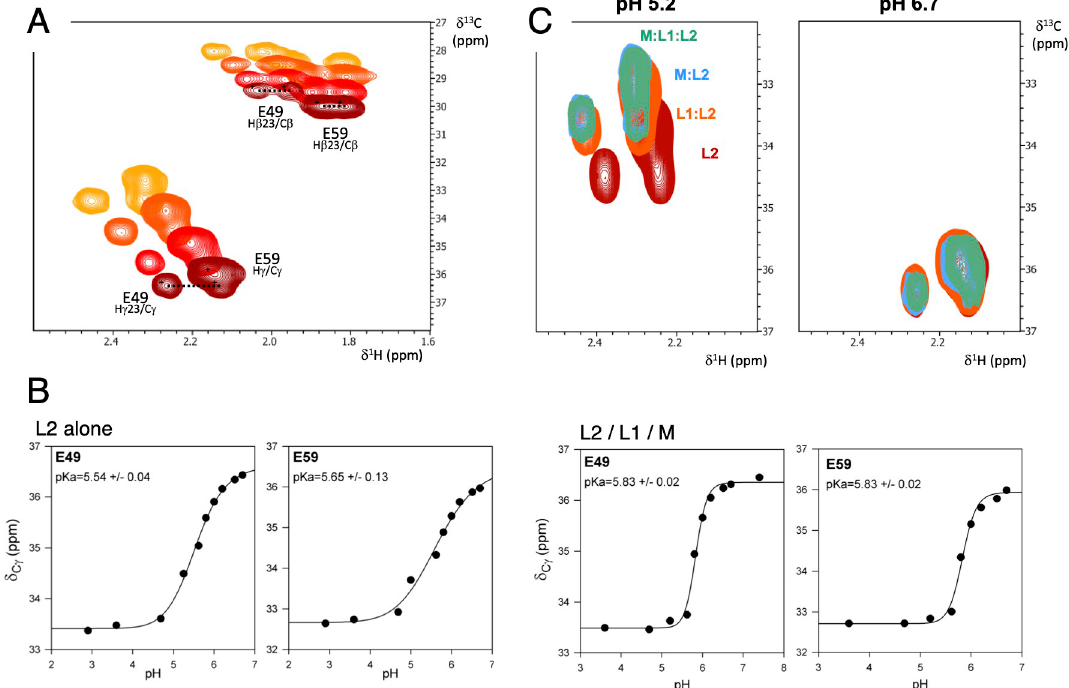
Fig 5. GldL glutamate residues protonation probed by NMR. pKa determination of 13 C-Glu of free and complexed L2 peptide. (A) Two-dimensional 13 C-HSQC spectra of 1 mM L2 peptide ( 13 C-Glu labeled) in 150 mM deuterated DPC in 50 mM phosphate buffers at different pH (pH 2.9 (yellow), 5.0 (orange), 5.8 (red), 6.7 (brown)). (B) The pH dependent chemical shift variations of C γ carbons of E49 and E59 of the L2 peptide free or complexed with L1 and M in a 1:1:1 molar ratio, were measured, fitted, and apparent pKa values were calculated using the Henderson–Hasselbach equation. Data underlying this figure can be found in S1 Data. (C) Two-dimensional 13 C-HSQC spectra of 1 mM L2 peptide ( 13 C-Glu labeled) in 150 mM deuterated DPC in 50 mM phosphate buffer at pH 5.2 (left panel) and pH 6.7 (right panel), in the absence (brown) and presence at molar ratio 1:1 of GldL-TMH1 peptide (L1, orange), GldM-TMH peptide (M, blue), and both L1 and M peptides (green). DPC, dodecylphosphorylcholine; NMR, nuclear magnetic